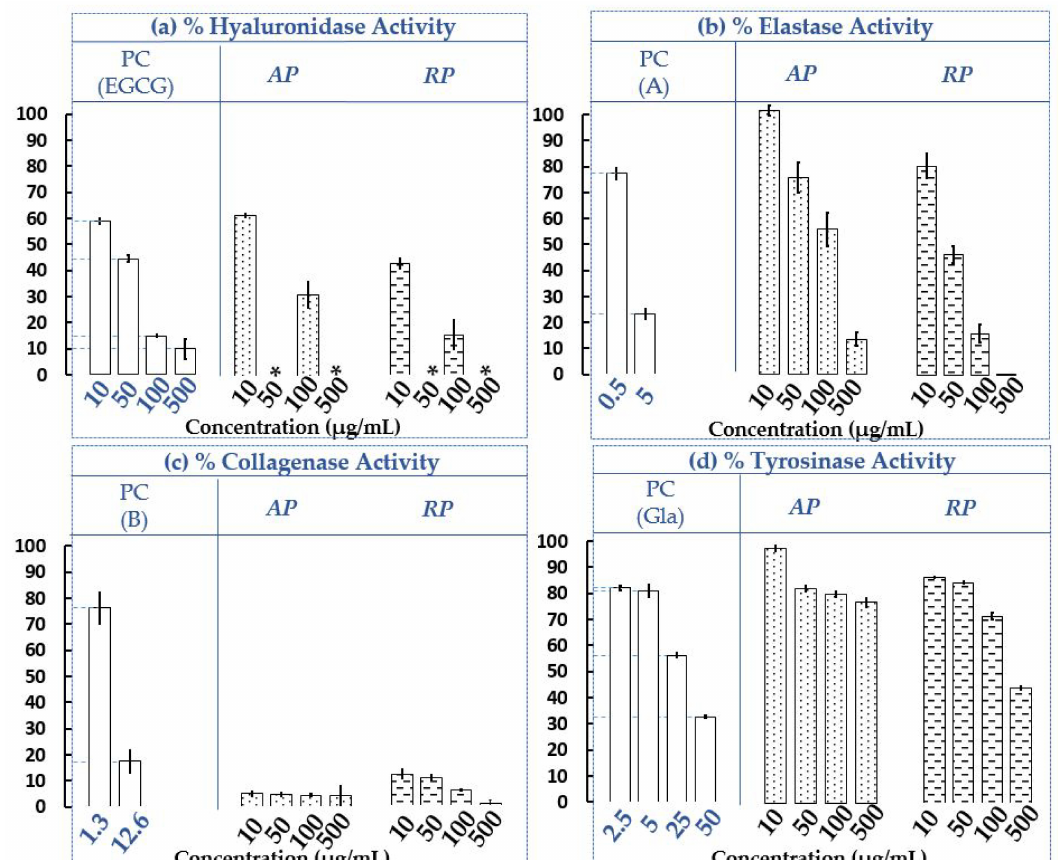
Figure 3. Evaluation of hyaluronidase ( a ), elastase ( b ), collagenase ( c ) and tyrosinase ( d ) residual activities of ethanolic extracts of AP and RP of invasive P. cuspidatum . PC = Positive Control; (EGCG) = epigallocatechine gallate; (A) = N-Methoxysuccinyl-Ala-Ala-Pro-Val-chloromethyl ketone; (B) = 1,10-Phenanthroline, monohydrate and (Gla) = glabridin. n = 3 independent experiments for each concentration ( µ g/mL). Bars depict ± S.D. * NT = Not